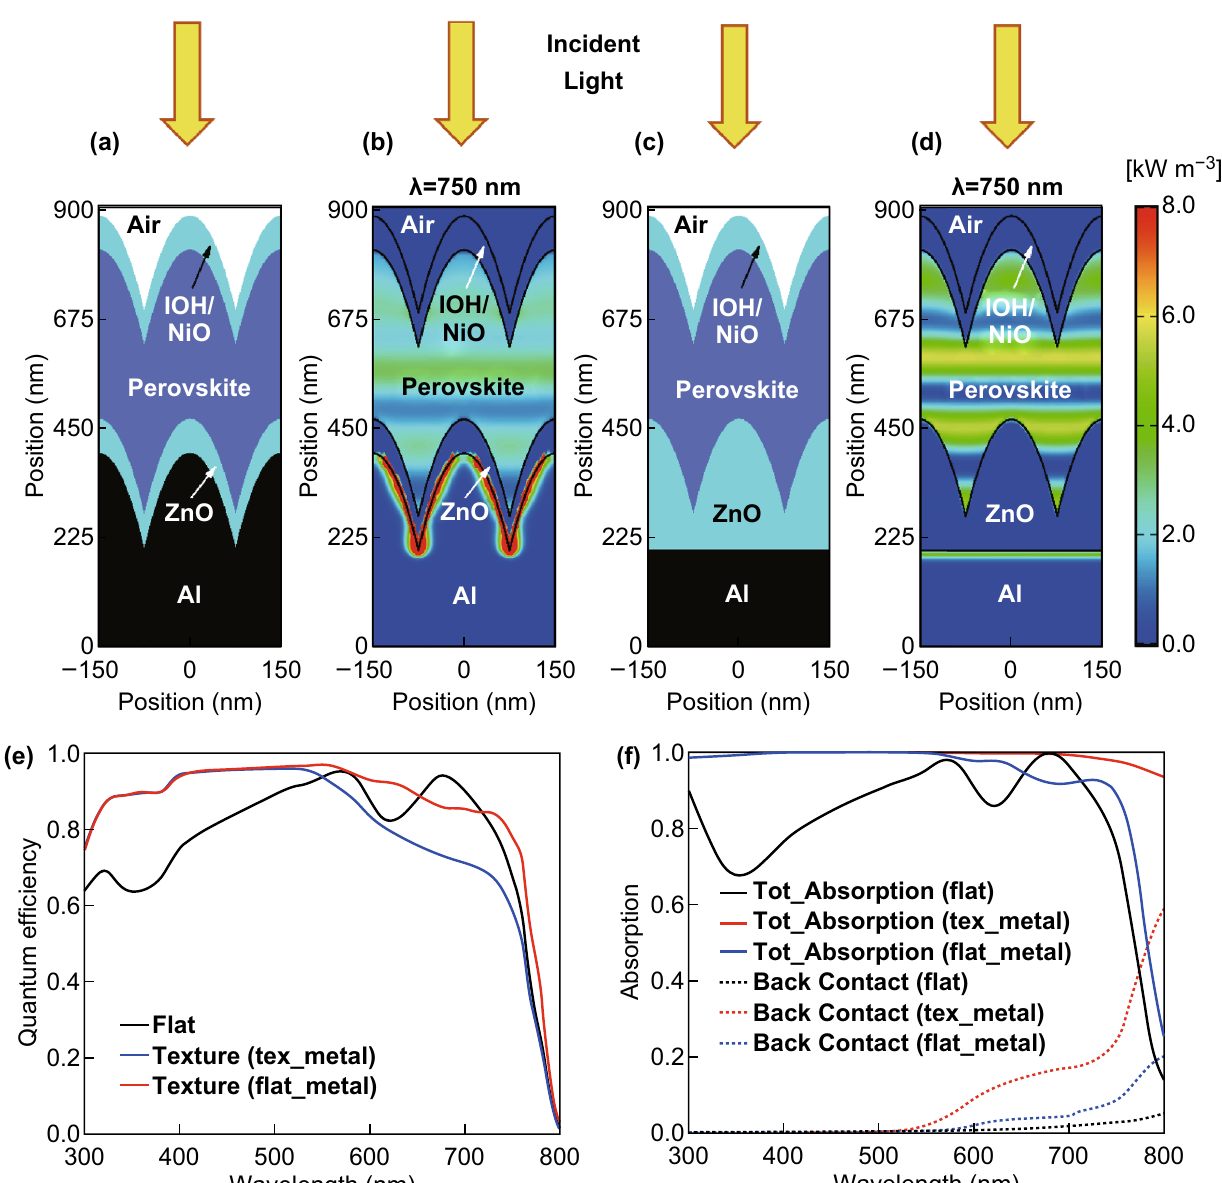
Fig. 13 Schematic cross sections of a perovskite solar cell with integrated moth eye textures. a An aluminum contact with a moth eye texture is formed and all subsequent layers of the solar cell are formed on the textured metal contact. Hence, all layers of the solar cell exhibit a moth eye texture. c A moth eye textured interlayer is form on a flat or planar aluminum reflector. All layers are formed on the moth eye texturized inter- layer. Hence, all layers except the aluminum back contact exhibits a moth eye texture, and b, d corresponding power density maps for an incident wavelength of 750 nm. Periods and heights of the moth eye structures are 150 and 200 nm, respectively. e Comparison of calculated quantum efficiency and optical loss of the metal back contact, and f comparison of absorbance for perovskite solar cells with and without integrated